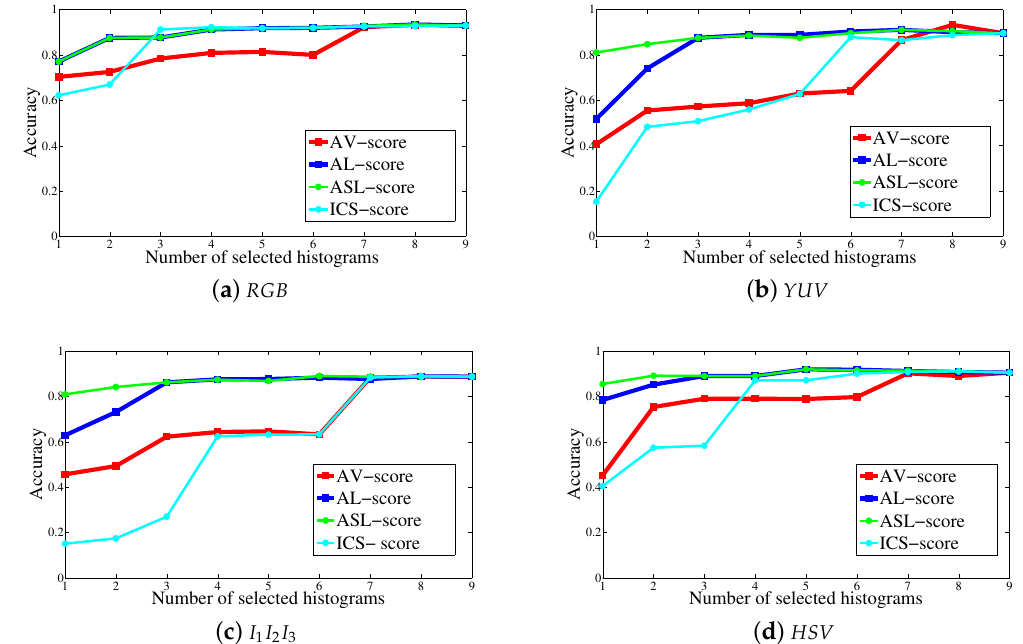
Figure 1. Classification accuracy R d according to the number d of ranked histograms on